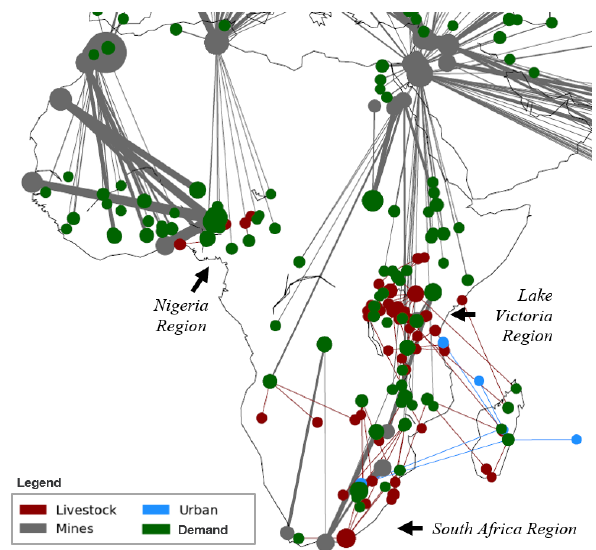
Figure 1. Dominant network pattern of potential trade in recovered P (on top of rock based